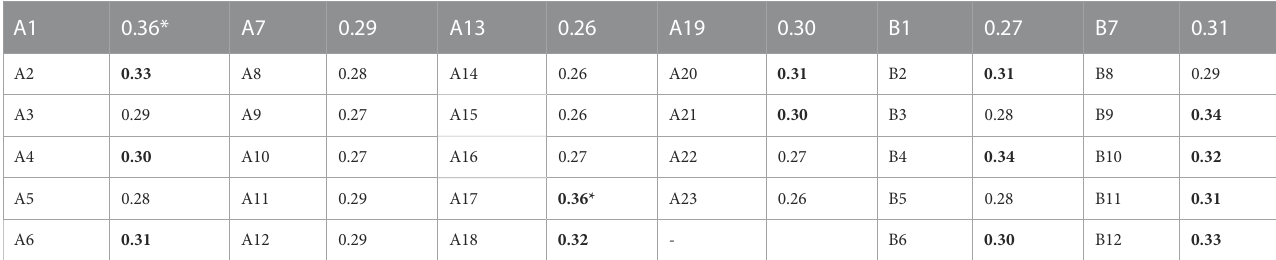
TABLE 2 Coef fi cient of deviation values of explanatory